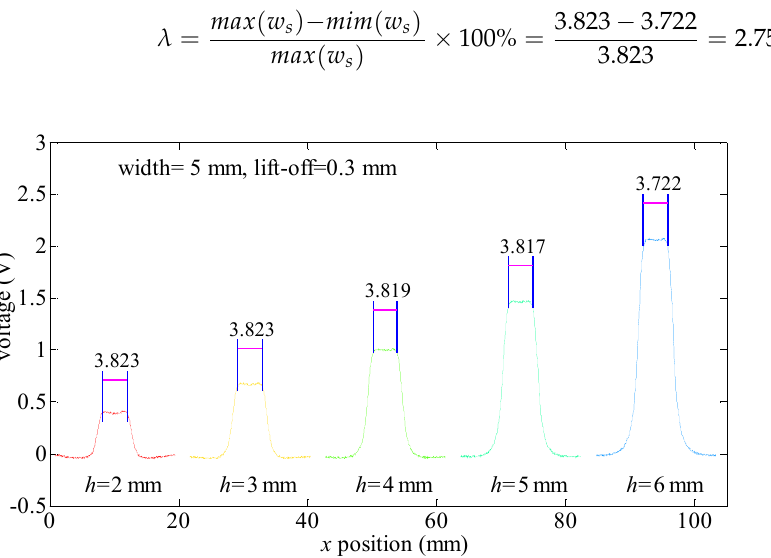
Figure 13. MFL testing signals for different depth values.